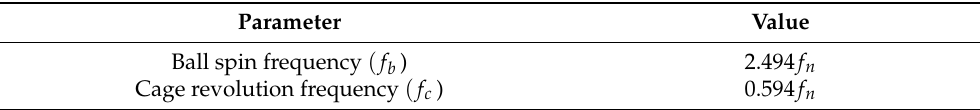
Table 3. Bearing characteristic frequencies of test